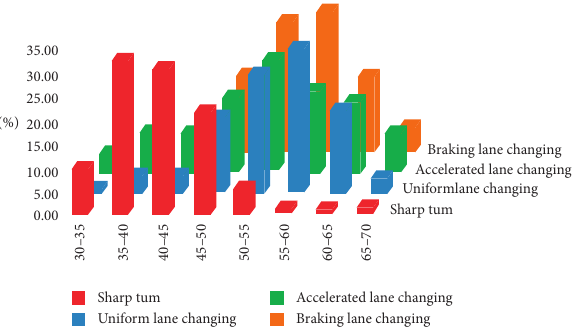
Figure 6: The histogram of driving speed ratios under different test conditions.